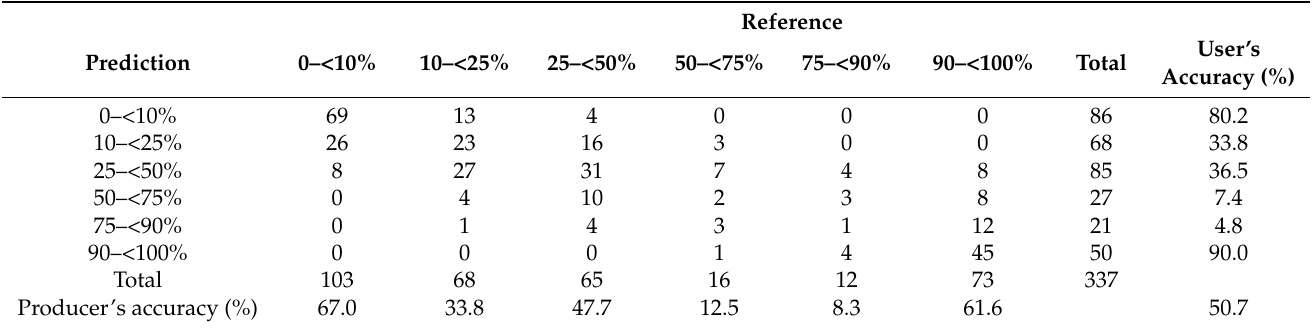
Table A13. Confusion matrix for Southwest model predicting IA scorch-adjusted canopy cover change with Sentinel-2 dNBR with offset.